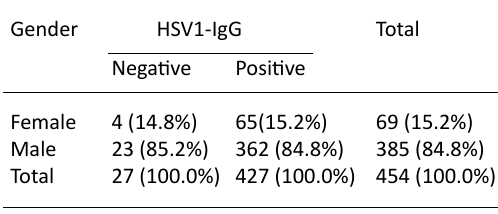
Table 2. HSV-1 Seroprevalences in Iraqi healthy blood donors, grouped according to